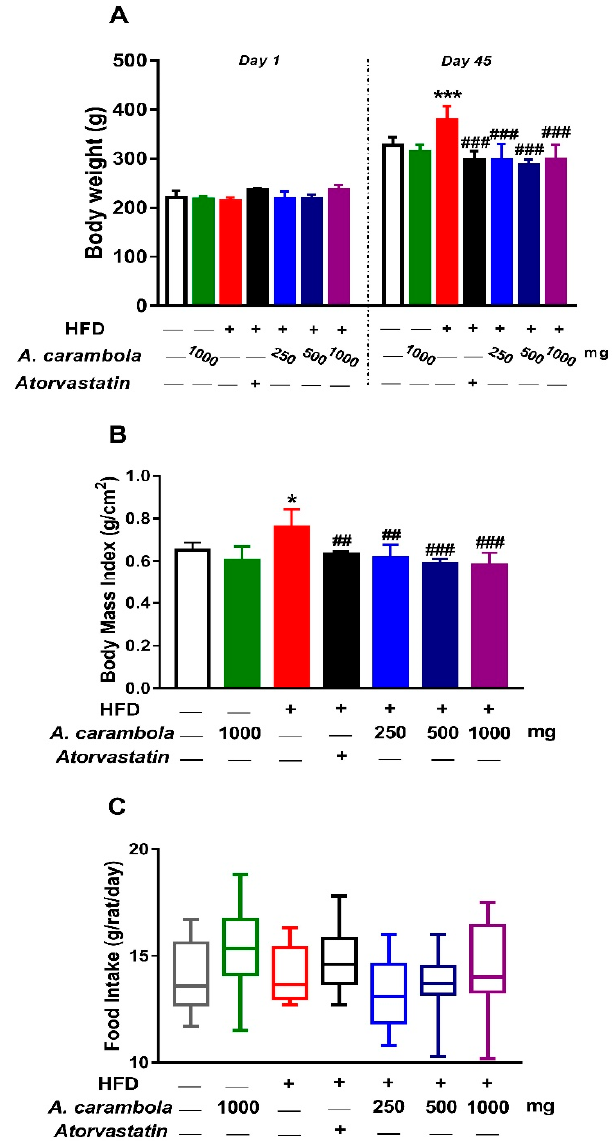
Figure 2. Body weight ( A ), body mass index ( B ), and food intake ( C ) of high-fat diet (HFD)-induced hyperlipidemic rats after treatment with various doses of MEACL for five weeks. Values are represented as mean ± SEM, n = 6. * p < 0.05, *** p < 0.001 compared to normal control. ## p < 0.01, ### p < 0.001 compared to hyperlipidemic control.